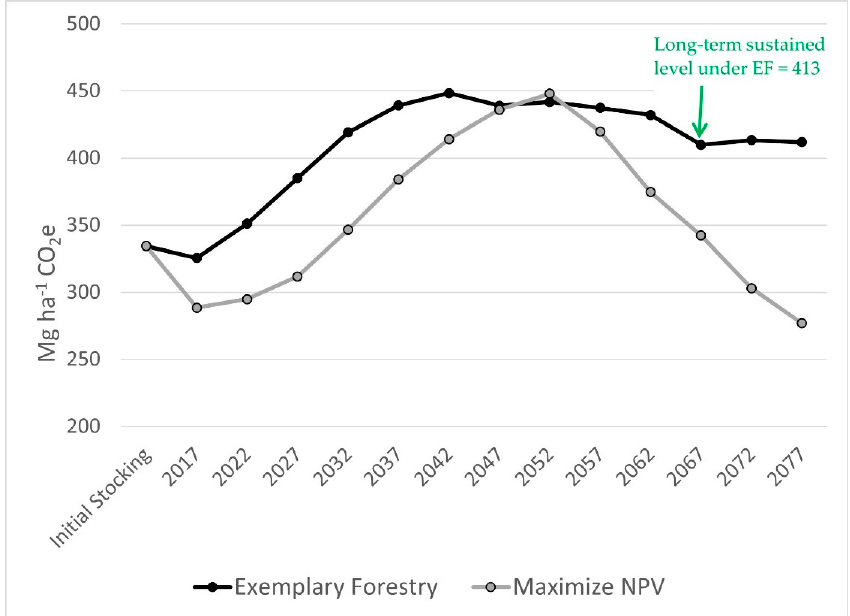
Figure 6. In-forest carbon storage from practicing Exemplary Forestry vs. maximizing short-term cash flows (or net present value) over 60 years in a forest representative of the Mountains of the Dawn region. See Figure S5 for more detailed results.